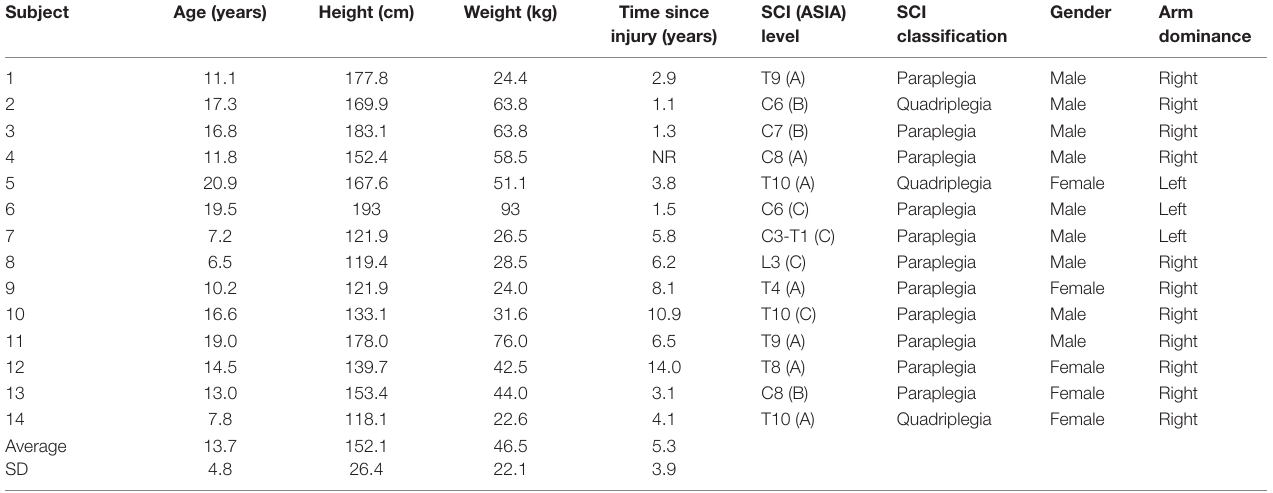
TaBle 1 | subject characteristics for each subject and the calculated group averages and sDs.